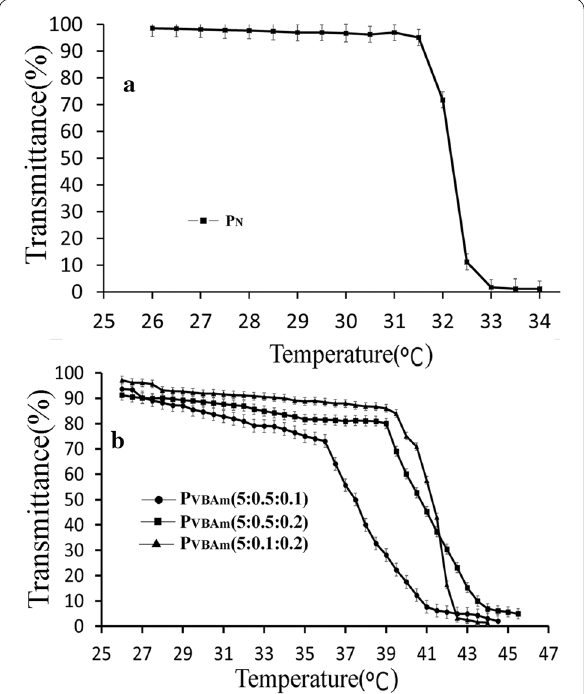
Fig. 4 Transmittance of P VBAm and P N with varying monomer ratios at different temperature in 5% (w/w) aqueous solutions, as measured by UV–vis spectroscopy. a for P N and b for P